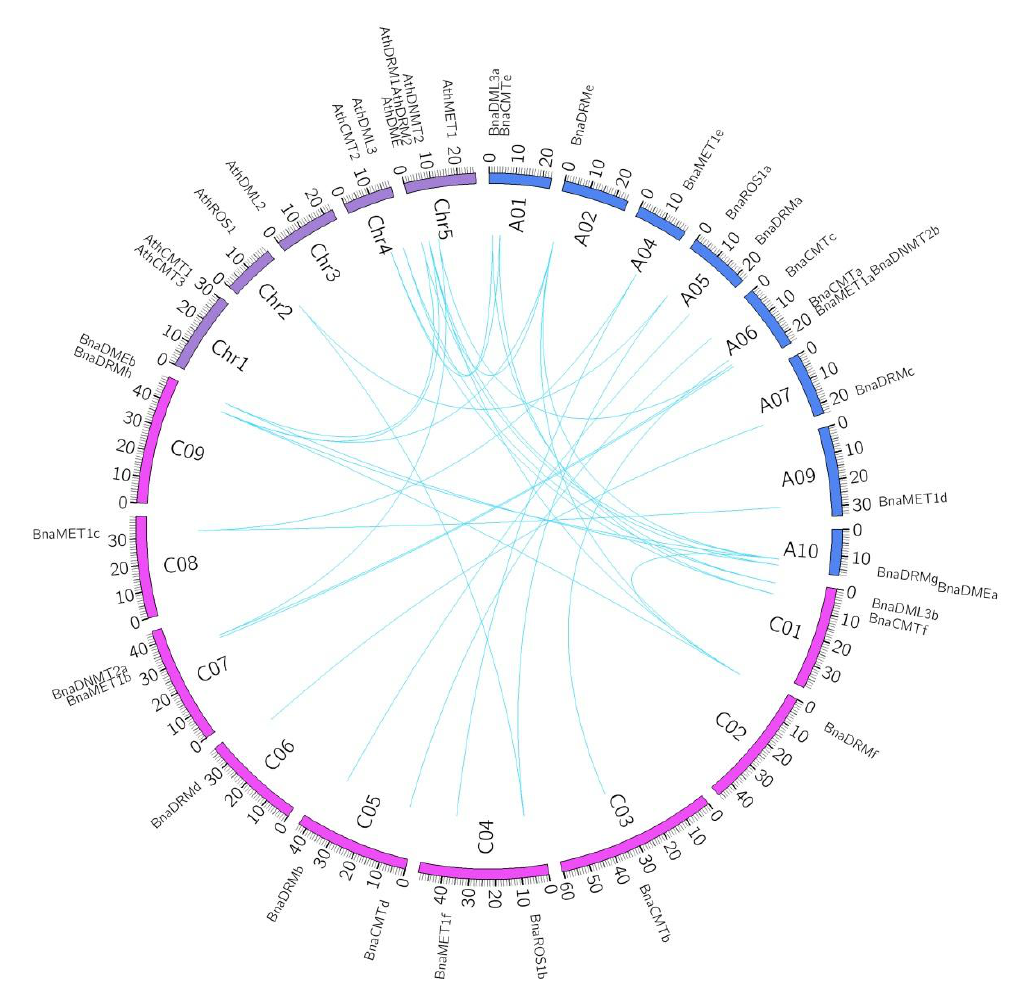
Figure 3. Synteny analyses of rapeseed DNA-MTase and DNA-deMTase families’ genes between B. napus and Arabidopsis . A01 to A10 and C01 to C09 represent the ten and nine chromosomes in the A n and C n subgenomes in B. napus , respectively. Chr1 to Chr5 represent the five chromosomes in Arabidopsis . Syntenic regions between B. napus and Arabidopsis are represented by blue